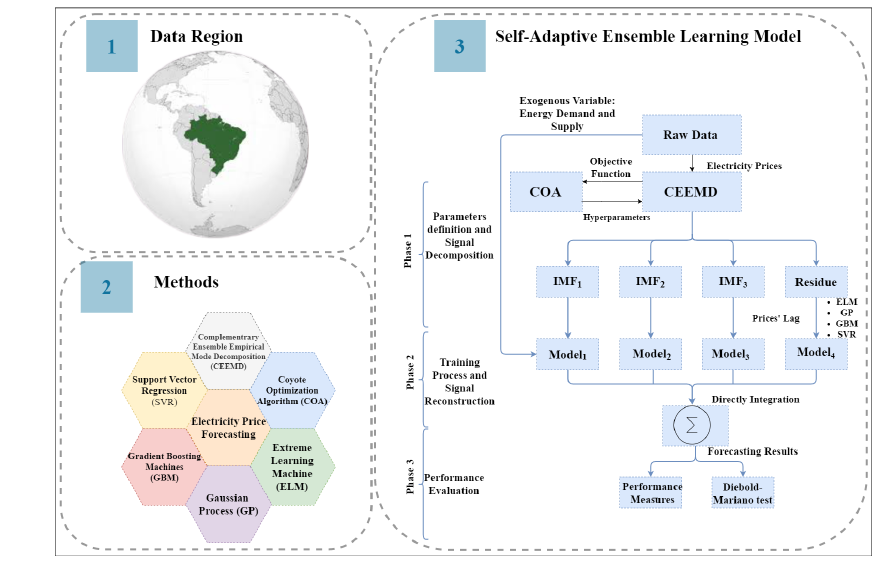
Figure 6. Framework of proposed